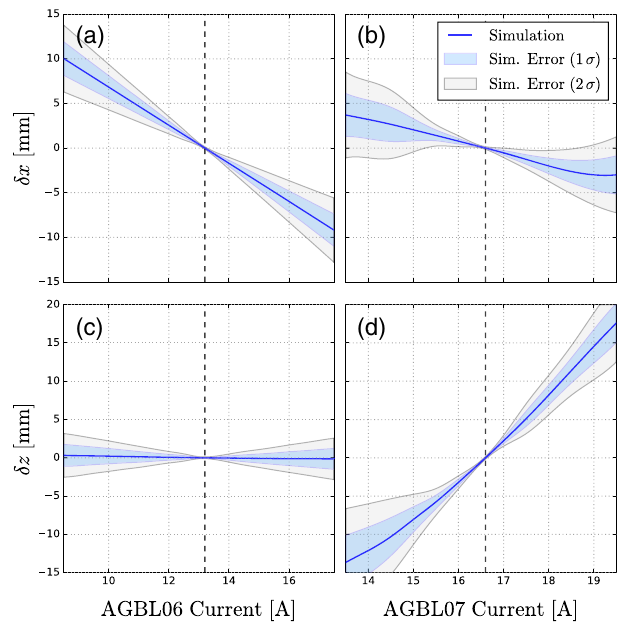
FIG. 8. Simulated steering scans showing the ¯ p beam position at the LDS as a function of the AGBL06 [panels (a) and (c)] and AGBL07 [panels (b) and (d)] interconnect magnet currents. The beam position has been separated into orthogonal components along the x and z axes of Fig. 7(a). In these simulations, the ALPHA-g external solenoid is powered with a nominal magnetic field of 1.0 T. The shaded regions indicate uncertainties in the beam position due to typical mechanical errors along the full ¯ p